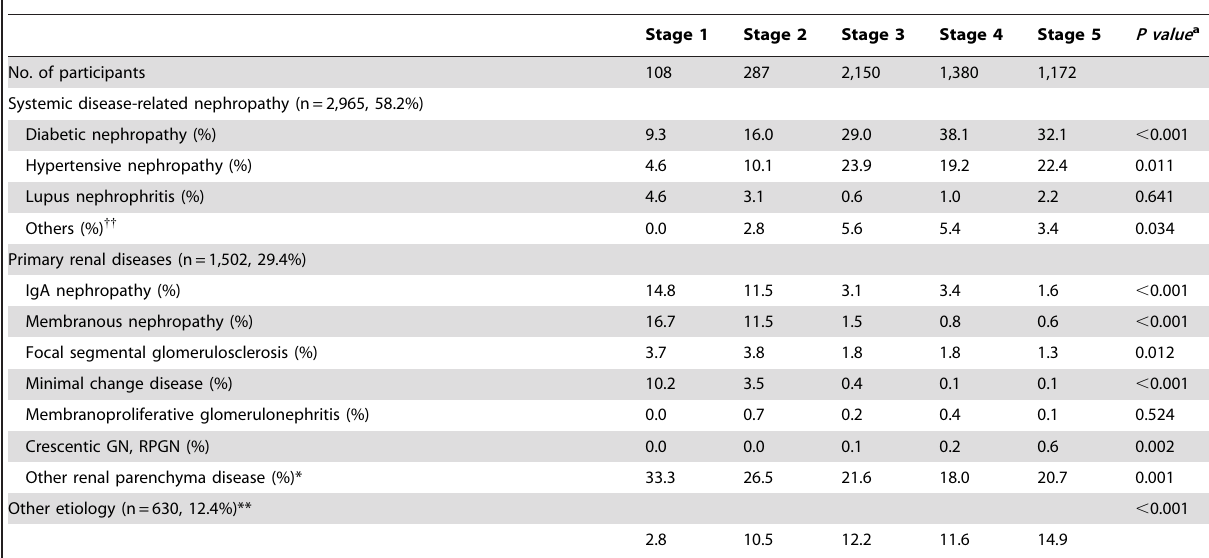
Table 2. Diagnosed etiologies by different initial CKD